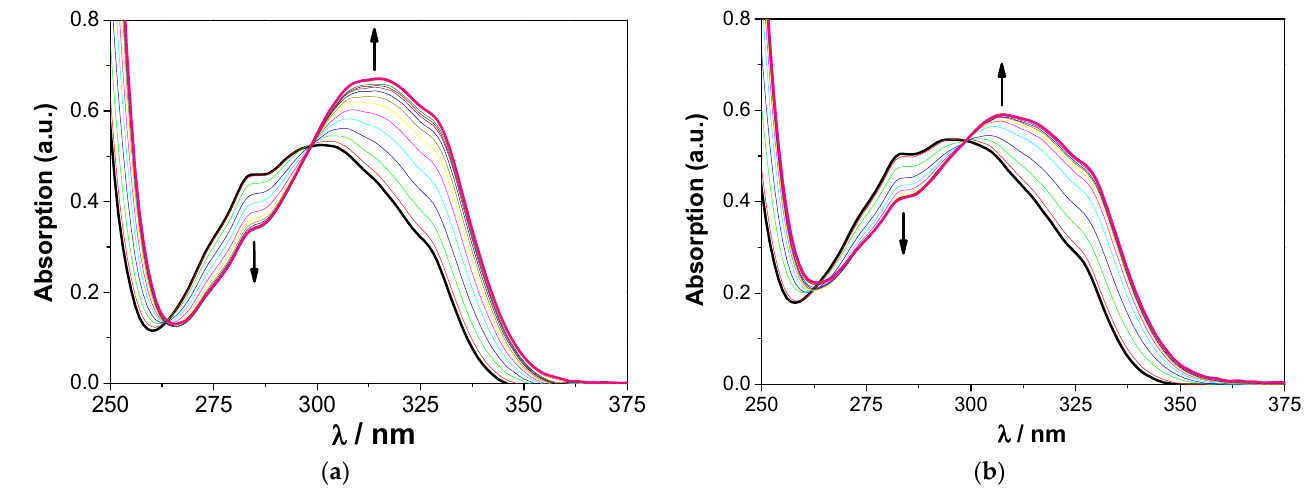
Figure 3. Changes in the UV spectrum of urea 4a (2.0 × 10 –5 M) upon addition of TBA F (up to 10 equiv.) in ( a ) CH 2 Cl 2 and ( b ) MeCN. The arrows indicate the effect of increasing amounts of salt.